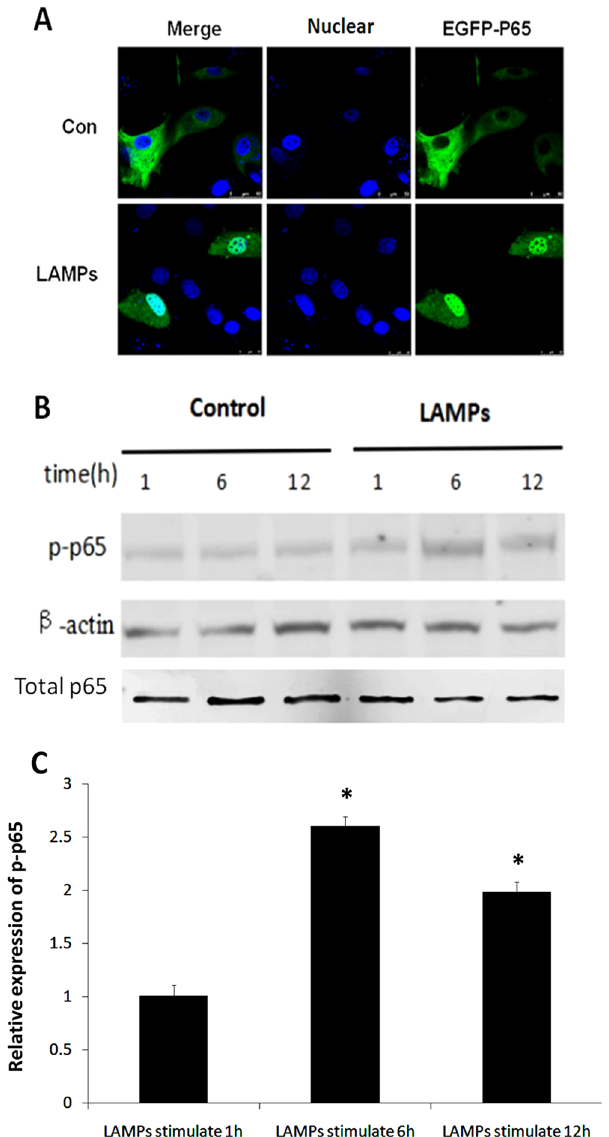
expression plasmid (pEGFP-p65) for 24 h and then stimulated with 1.0 μ g/mL LAMPs for 6 h. Nuclei were counterstained with 1 μ g/mL DAPI, and NF- κ B nuclear translocation was observed using a laser-scanning confocal microscope. ( B ) EBL cells were stimulated for the indicated times with 1.0 μ g/mL LAMPs, and Western blot analyses were performed with antibodies specific for bovine p65 and p-p65. β -Actin was used as a loading control. ( C ) Band densitometry results from the western blot shown in ( B ). β -Actin was used for normalization. * p < 0.05 (Student’s t-